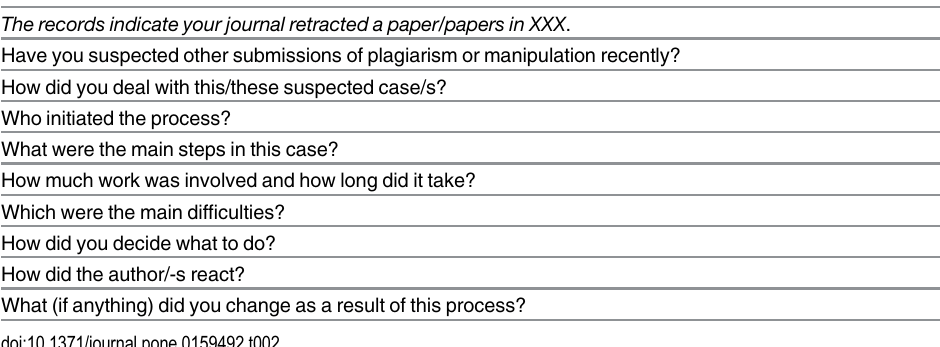
Table 2. Questions in Survey